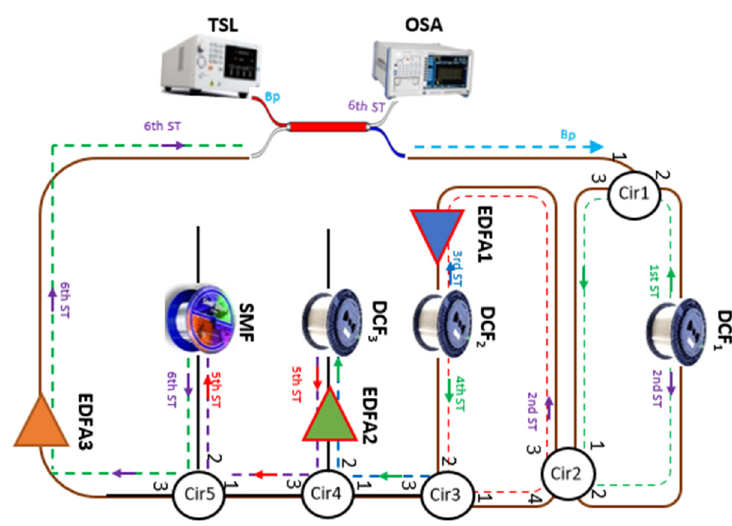
Figure 1. Experimental setup of the proposed cavity.